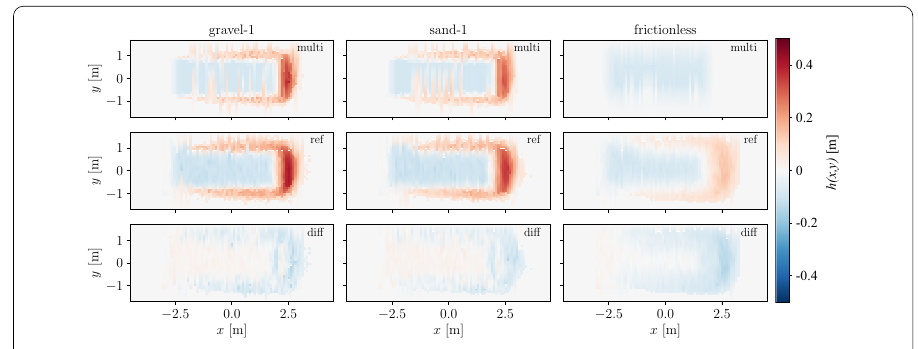
Fig. 12 The resulting surfaces from bulldozing in three frictional soils using the multiscale model (top row) and the microscale reference model (middle row). The difference is shown at the bottom row